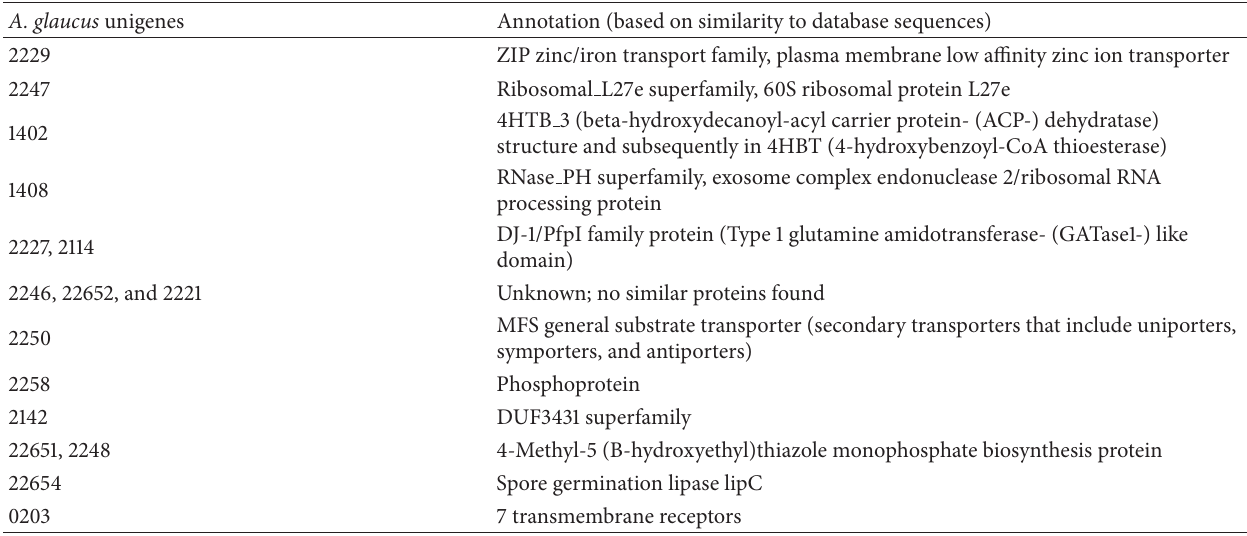
Table 3: A. glaucus coding sequences that were identified from the cDNA expression library as putatively conferring increased salt-resistance. A. glaucus unigenes